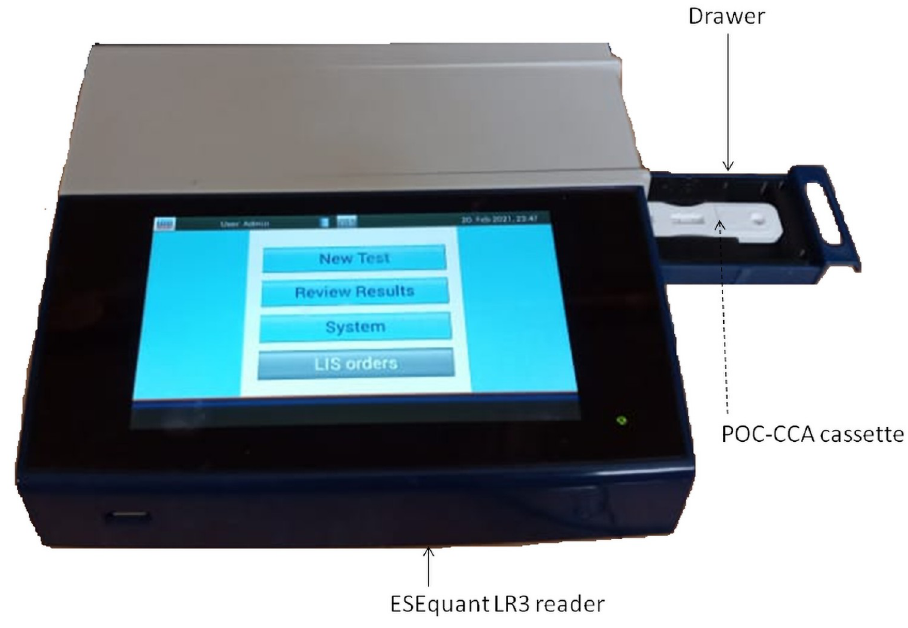
Fig 1. ESEquant LR3 lateral flow strip reader.